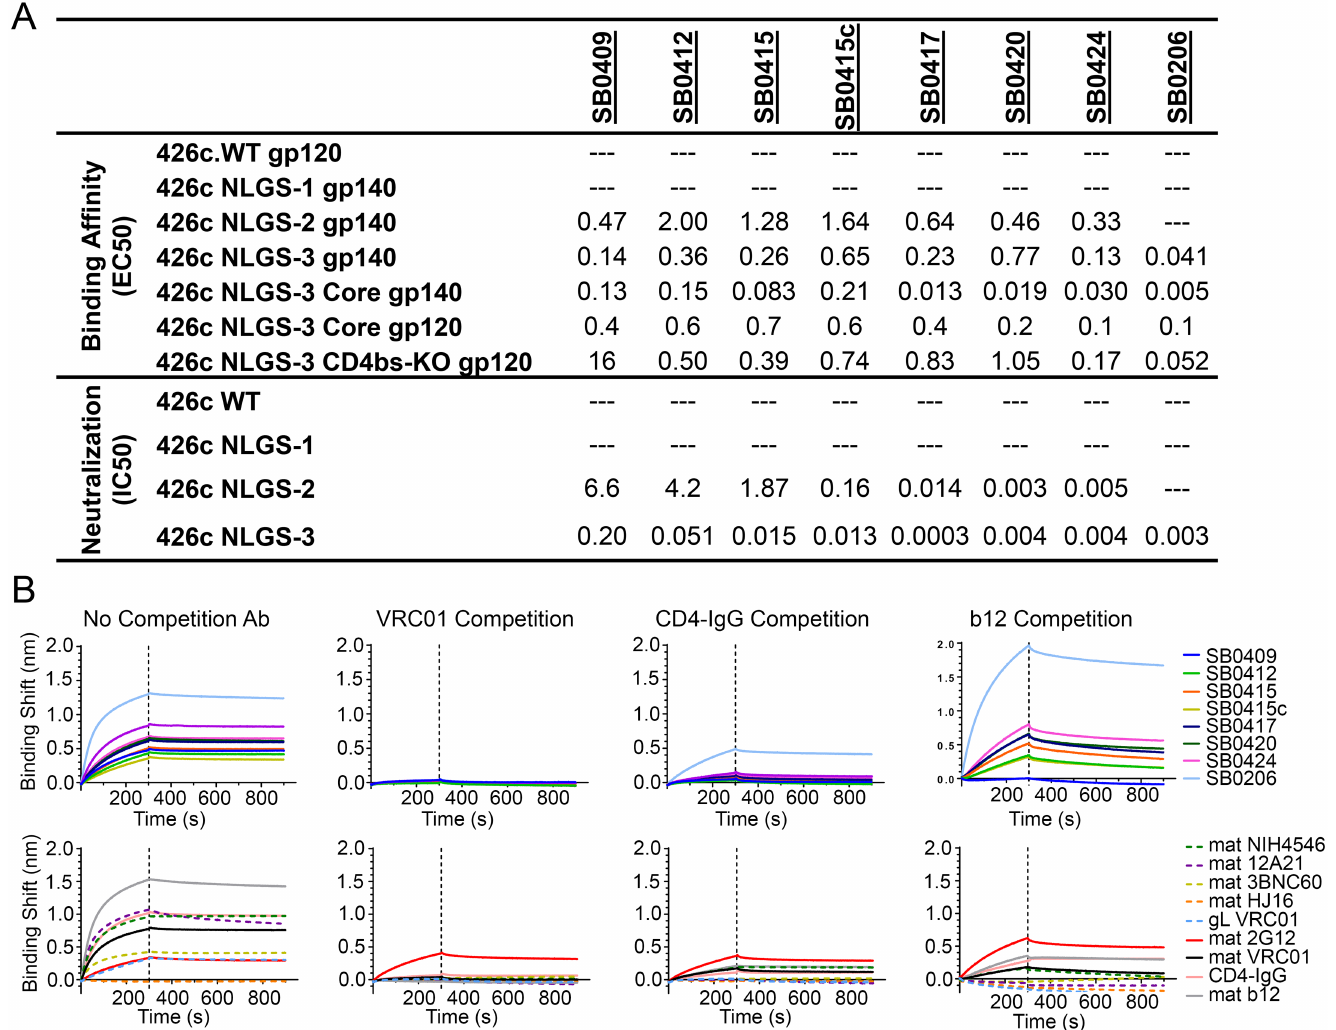
Fig 4. Binding and neutralizing potentials of MAbs isolated from the NLGS-3 Core immunized animals. (A) Binding ( top ) and neutralizing ( bottom ) titers of the indicated macaque MAbs against the indicated Envs and viruses. (B) Antibody-binding competition. Top panels: The binding of the indicated macaque MAbs to the 426c NLGS-3 Core gp140 protein was determined in the absence of competing antibody (left) ,or following the pre-incubation of 426c NLGS-3 Core gp140 with saturating concentrations of VRC01 (middle left) ,CD4-IgG (middle right) , or b12 (right) . Bottom panels: Control experiments were performed with the indicated human MAbs. Direct binding of the indicated human MAbs to the 426c NLGS-3 Core gp140 protein ( leftpanel ), following the pre-incubation of Env with VRC01 ( second from left panel ), CD4-IgG ( second from right panel ), or b12 ( right panel ).